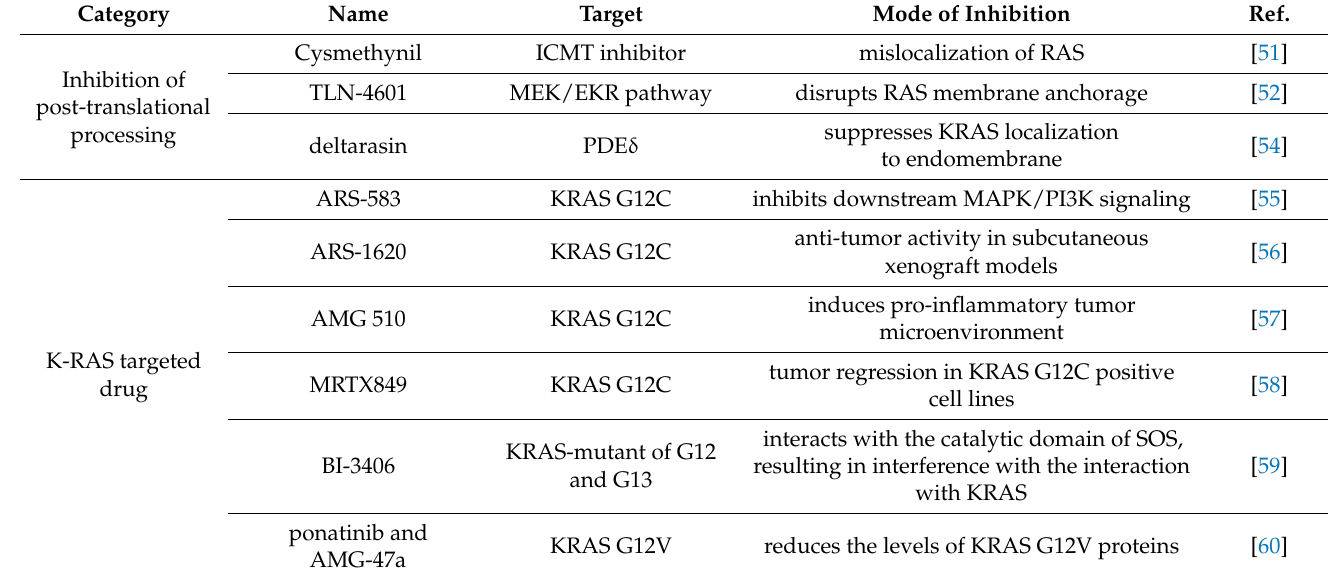
Table 1. Summary of therapeutic strategies towards RAS-driven